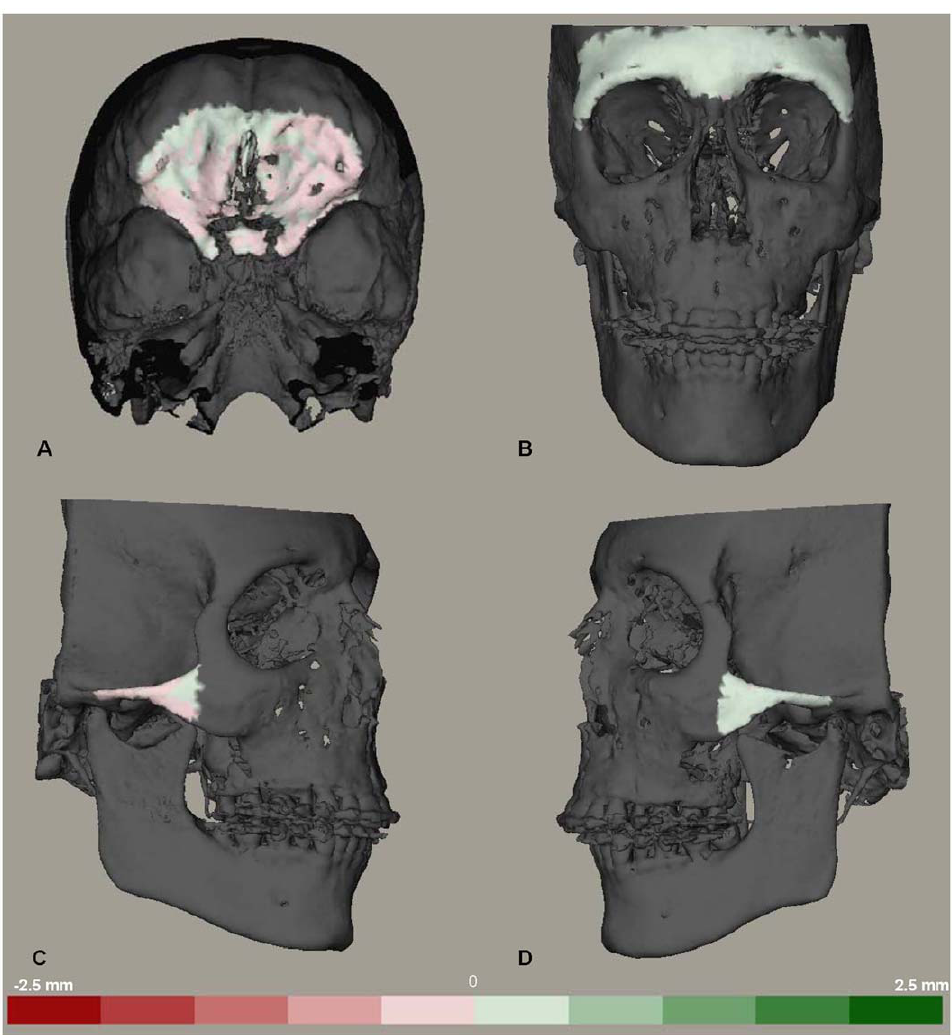
Figure 6. Distance maps to visualize the distances between two models registered on the anterior cranial base. Color coded distance maps to visualize the distances between two superimposed models registered on the anterior cranial base. The green color indicates that the superimposed model is in front of the original model and red color indicates the opposite. Each color graduation is 0.5 mm. (A) anterior cranial base. (B) the forehead region. (C) the right zygomatic arch. (D) the left zygomatic arch.